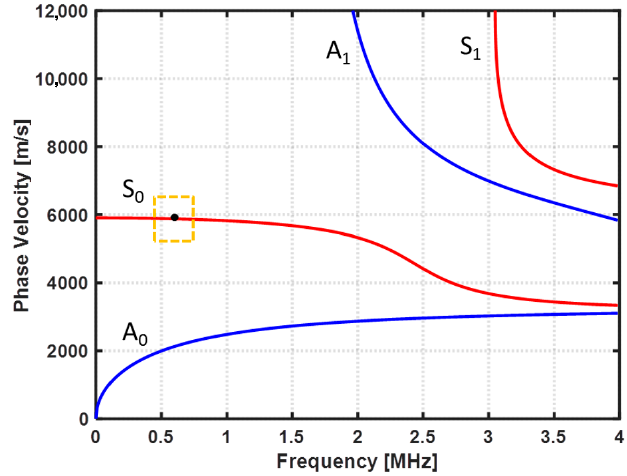
Figure 3. Phase-velocity dispersion curves.